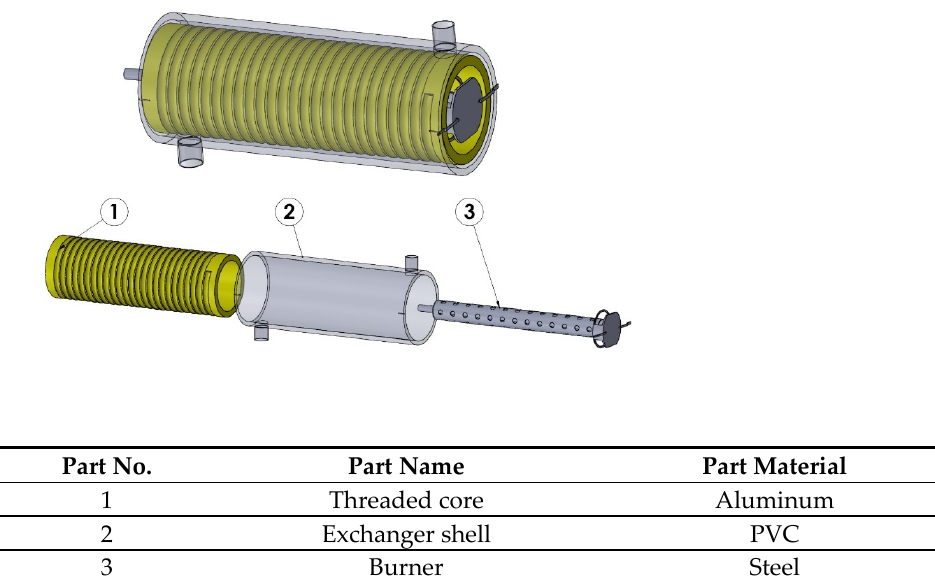
Figure 1. Schematic and speci fi cations of the designed STHE.